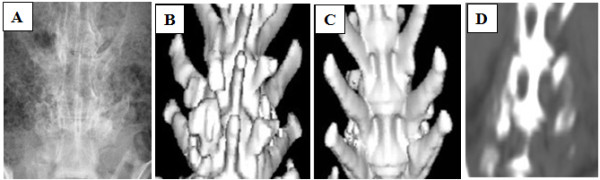
Results of plain radiographs (A), dorsal view (B) and ventral view (C) 3D CT scan images, and coronary reconstructive images (D) in groups of Alginate-MSCs without HBO treatment. A successful, continuous bone fusion mass with calcification was noted between the left intertransverse space. On the contrary, a scattered and uncalcified bone mass without fusion was noted between the right intertransverse space.